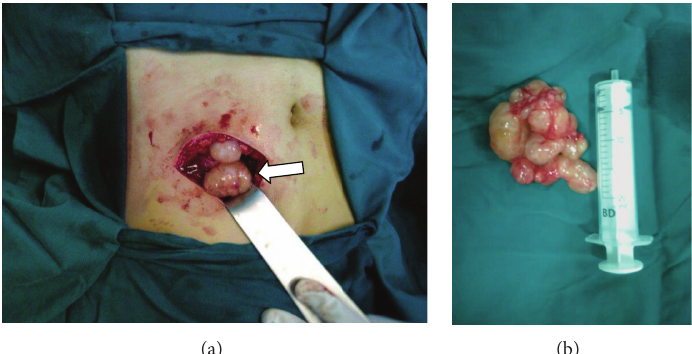
Figure 3: (a) Peroperative picture shows the superficial location of the mass (arrow). (b) Excised tumor.